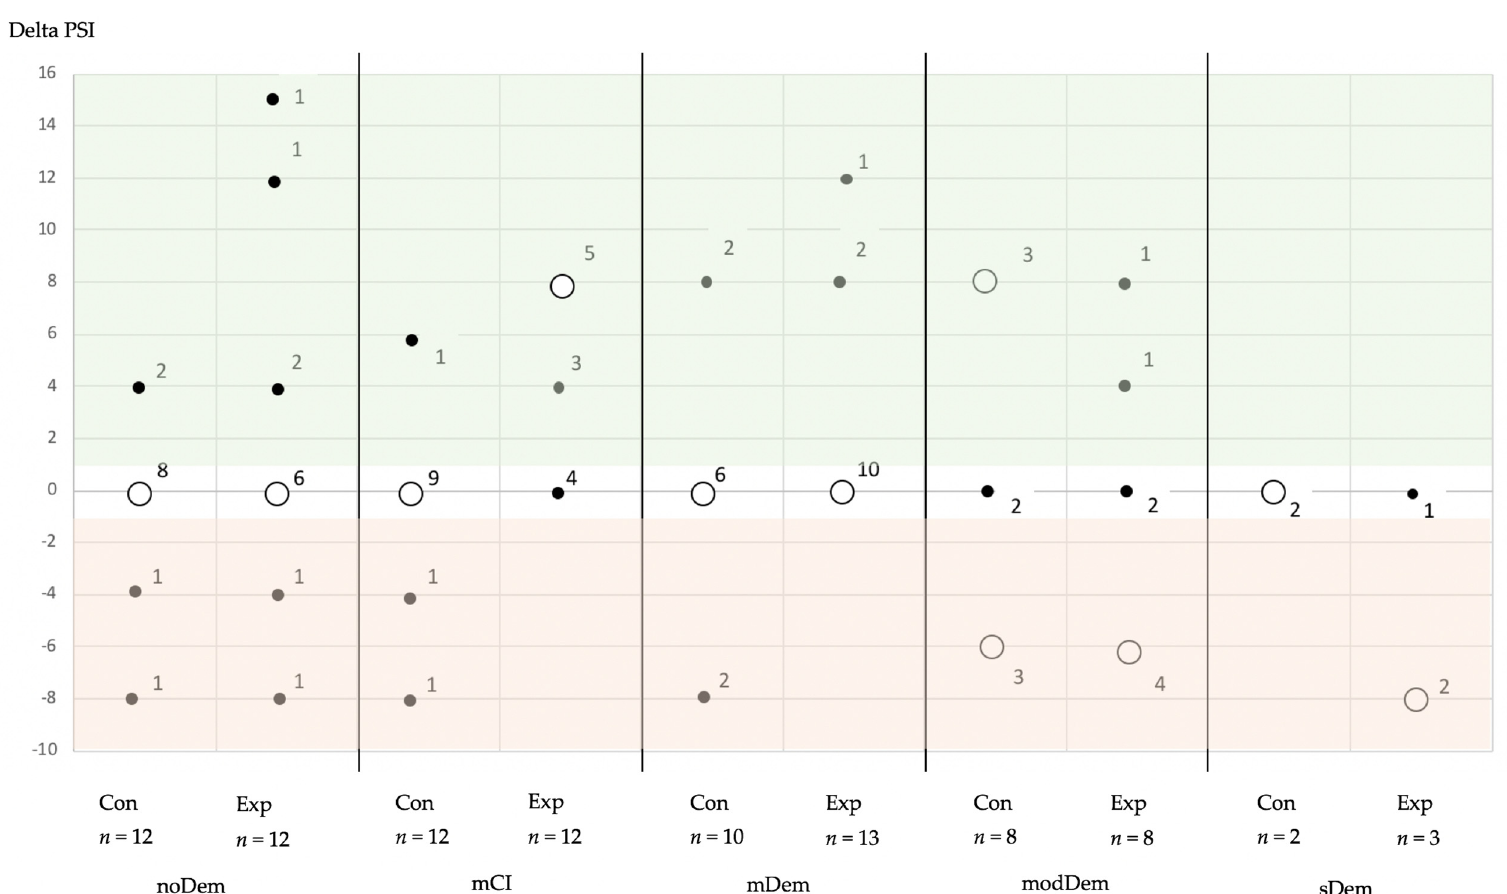
Figure 3. Changes in the periodontal screening index (PSI—code 0: healthy; code 1/2: gingivitis/calculus present; code 3: moderate periodontitis; code 4: severe periodontitis) over time separated by mini mental state examination (MMSE) group and subgroup (Con: control group; Exp: experimental group) after calculation of the quadratic weighted PSI code for baseline and final ( Δ PSI = baseline minus final) (color coding—red: deterioration over time; white: no change; green: improvement) (MMSE groups—noDem: no dementia; mCI: mild cognitive impairment; mDem: mild dementia; modDem: moderate dementia; sDem: severe dementia) (hollow circles correspond to the majority of counts of changes in each evaluation group, filled circles demonstrate minor amount of counts of changes in each evaluation group, numbers at hollow and filled circle correspond to number of changes).